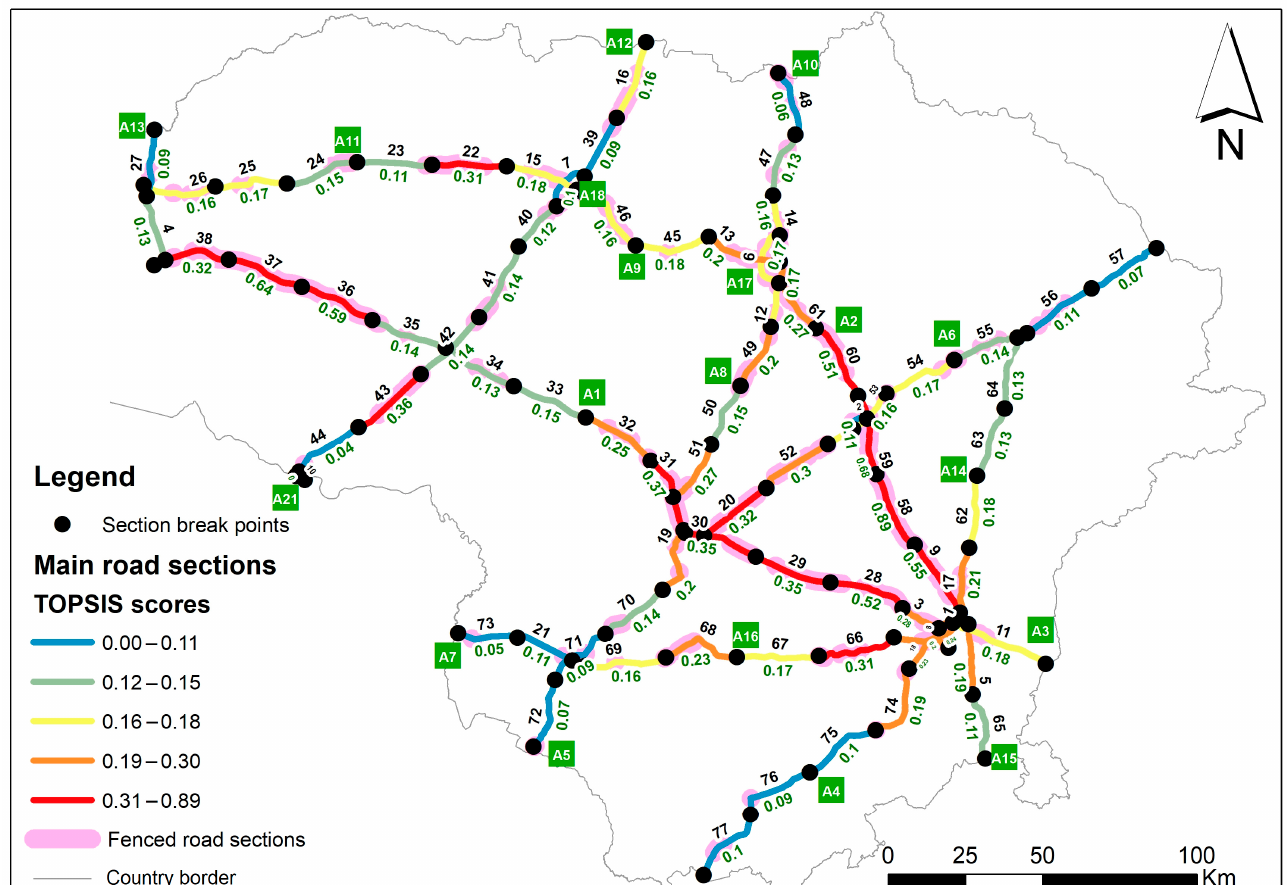
Figure 7. The road section ranking score quantile map. Road section labels (black labels) are placed above each section, while TOPSIS ranking scores are placed below road sections (green labels). Road numbers are on rectangular green labels shown as references.